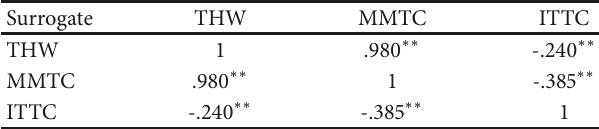
Table 2: Pearson correlation analysis of ITTC, THW, and